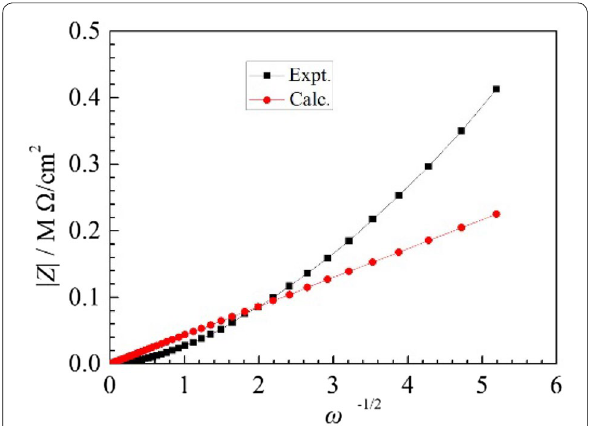
Figure 9 Fitting and experimental plots for the 304 stainless steels in borate buffer